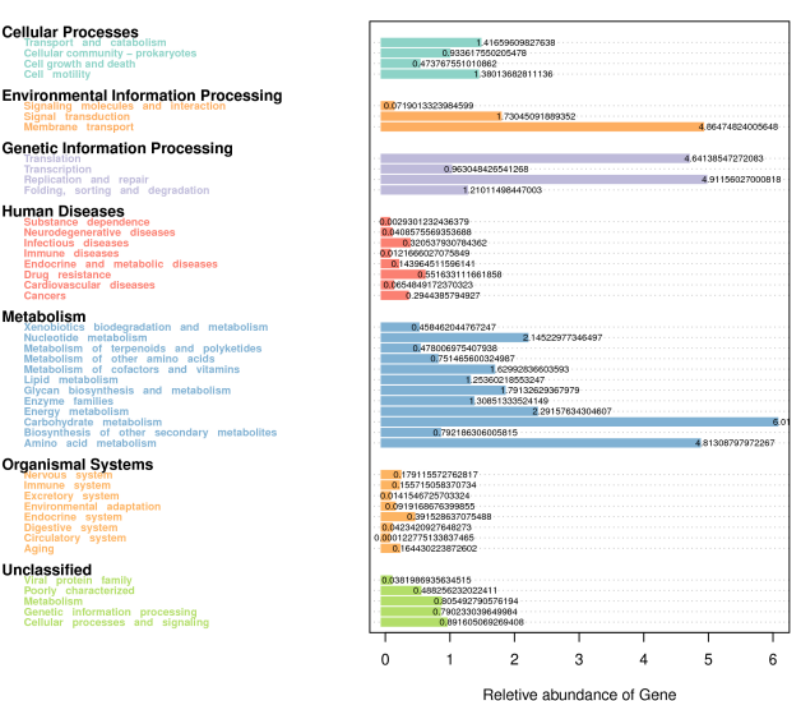
Figure 3. Statistical graph of the gene prediction function results of fecal microorganism via Tax4fun. CON, 0% FHTR in the diet; L15, 15% FHTR in the diet; L30, 30% (FHTR) in the diet.